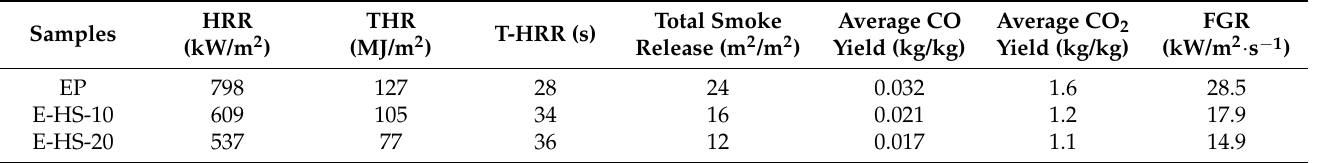
Table 2. Data from cone calorimetry tests.